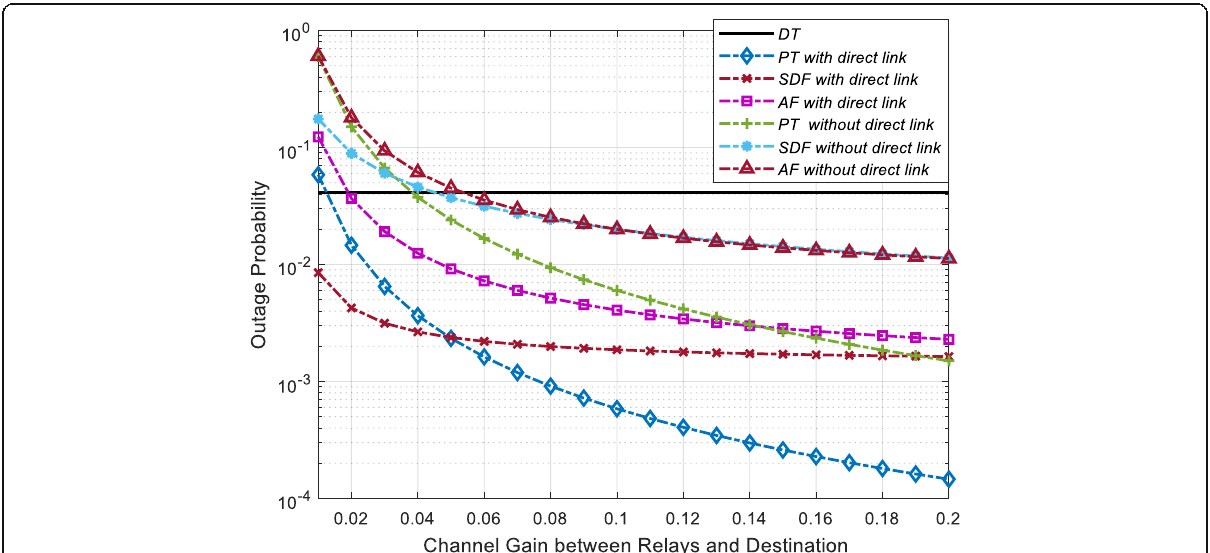
Fig. 8 Outage probability versus channel gain between relay and destination with two relays. The figure shows that the simulations on outage probability versus channel gain between relay and destination (R-D) of partial transmission (PT) and three conventional cooperative strategies, direction transmission (DT), selective decode-and-forward (SDF), and amplify-and-decode (AF), on the situations with two-relaying system. To simulate the unreliable relays, the simulation parameters are set as follows: the number of information bits is 100,000; the transmit SNR of source is 20 dB; other channel states from relays to destination (R-D) and source to destination (S-D) are set the same, as 0.1. In Fig. 8, in order to facilitate the analysis, we assume that the two R-D channels follow the same distribution. As the channel gain between relays and destination increases, the gain value that PT gets better than SDF is nearly half of it in one-relaying system, where the certain amount of location information of PT degrades some performance. Generally speaking, when the R-D channel is better than the severely attenuated S-D channel, i.e., the relays are considered to be unreliable, the performance of PT is better than that of the conventional strategies